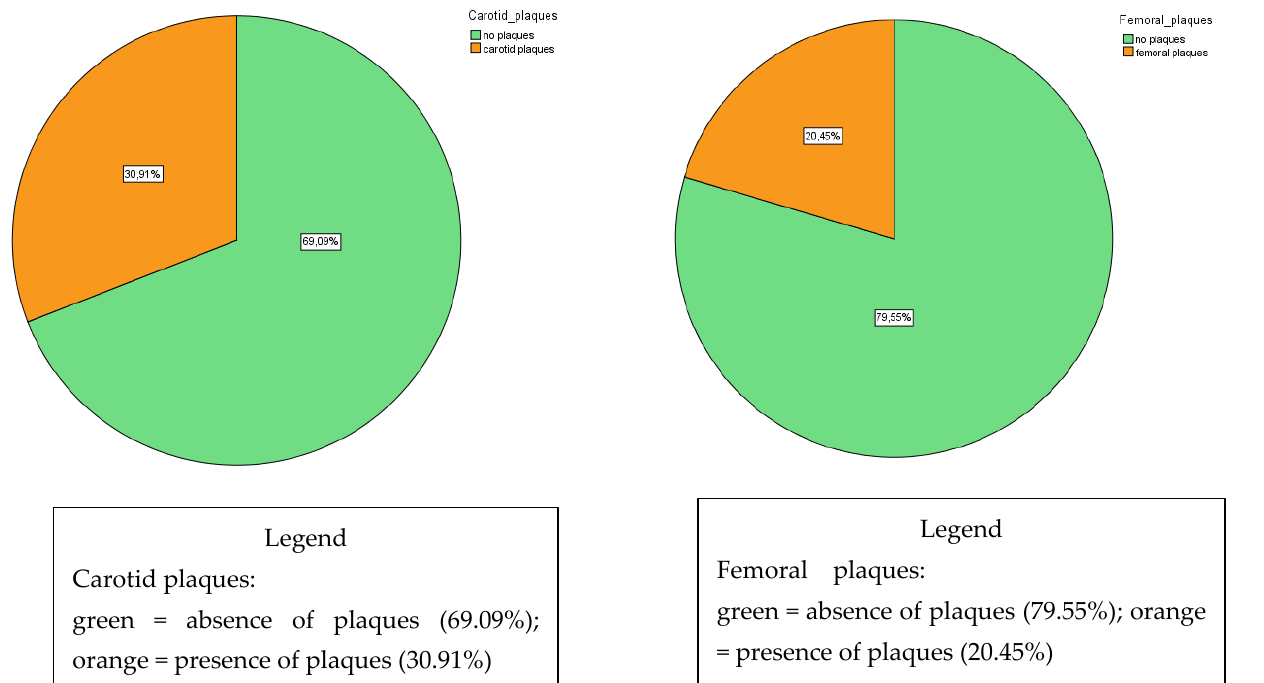
Figure 1. Prevalence of carotid and femoral plaques prior to initiating second- and third-generation tyrosine kinase inhibitors (nilotinib and ponatinib; n = 55).